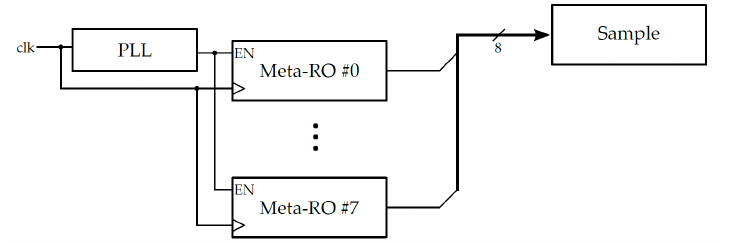
Figure 9. Sampling strategy for Meta-RO assessment.